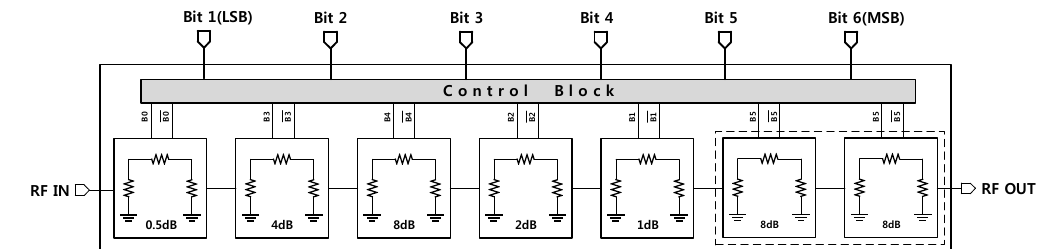
Figure 9. A block diagram of the 6-bit attenuator.